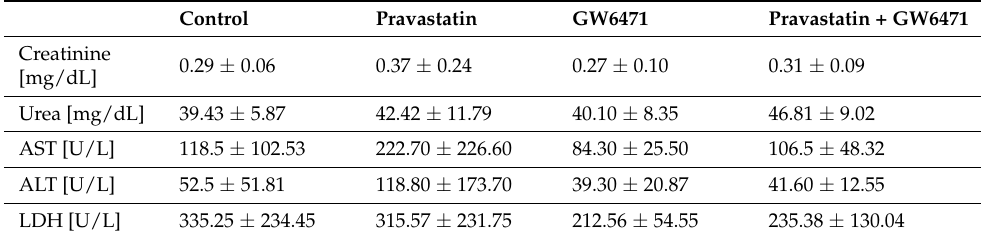
Table 2. Creatinine, urea, aspartate transferase (AST), alanine transferase (ALT) and lactate dehydro- genase (LDH) in control septic animals (control) and after treatment with pravastatin (Pravastatin), PPAR- α -antagonist GW6471 (GW6471) and a combination with both drugs (Pravastatin + GW6471). n =